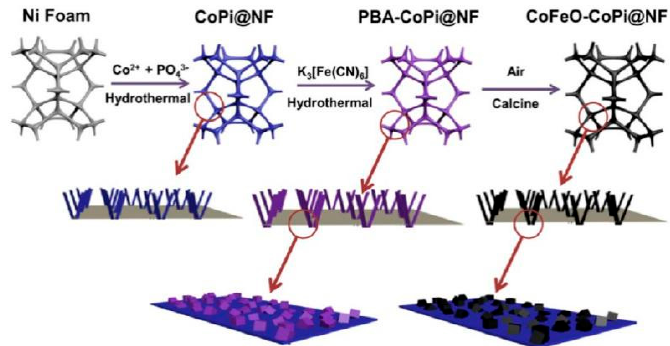
Figure 8. Schematic illustration of CoFeO-CoPi@NF. Adapted with permission from [87]. Copyright © 2020, American Chemical Society.